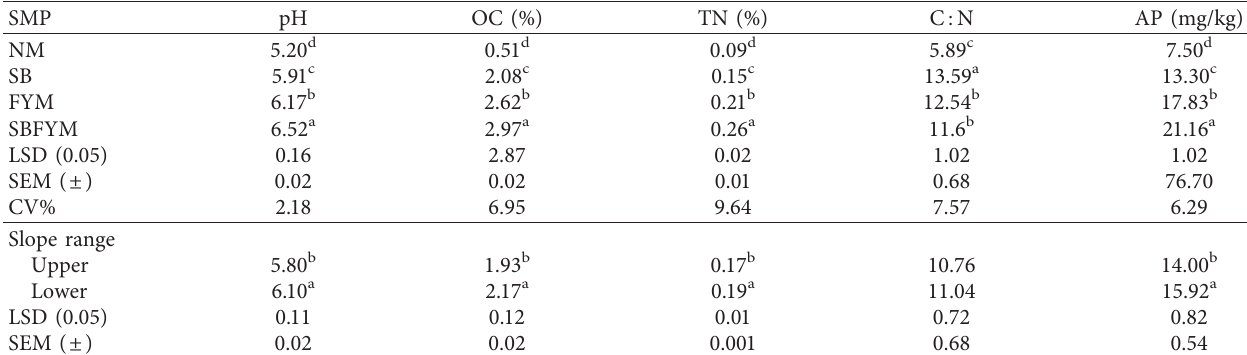
Table 4: Effect of soil management practices and slope range on soil chemical properties in Mawula watershed. SMP pH